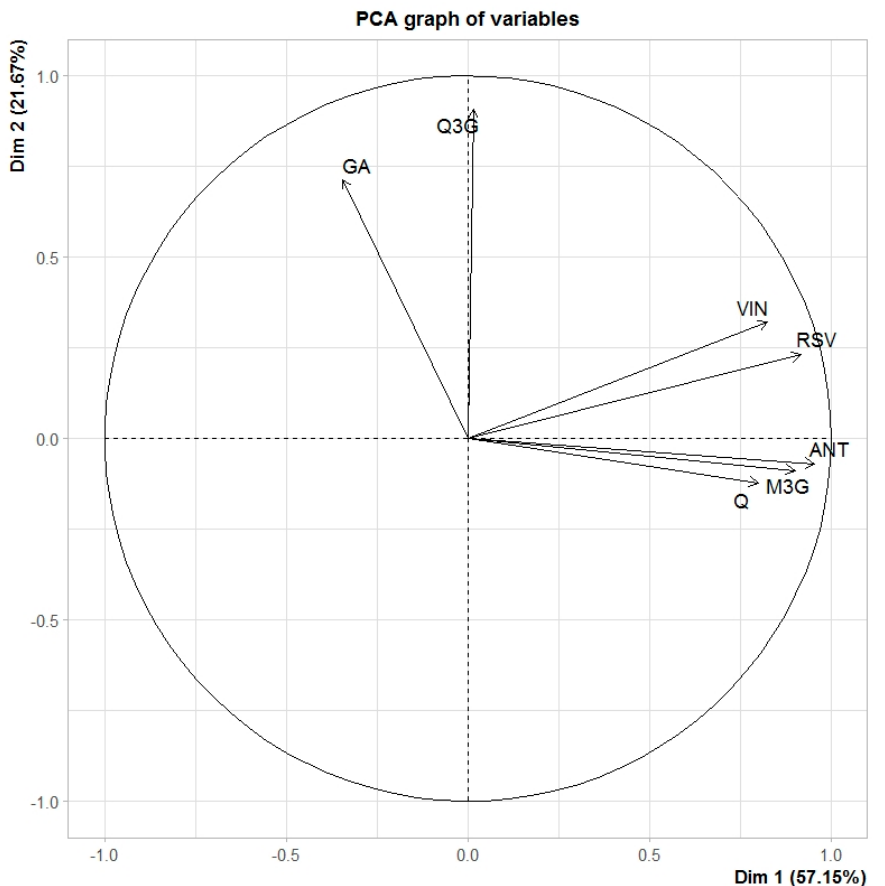
Figure 3. Principal Component Analysis of the following variables: gallic acid (GA), malvidin-3- glucoside (M3G), unknown anthocyanin (ANT), quercetin (Q), quercetin derivative (Q3G), resveratrol (RSV) and viniferin (VIN).